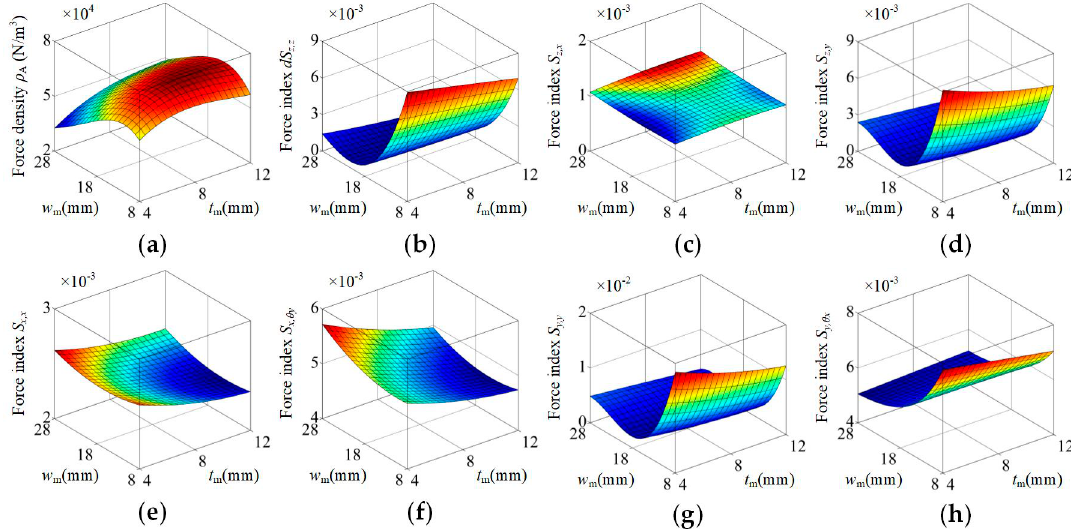
Figure 13. Force density and uniformity of the HMF-VCA varied with structural parameters w m and t m . ( a ) Force density ρ A . ( b ) Variation of F z caused by z . ( c ) Variation of F z caused by x . ( d ) Variation of F z caused by y . ( e ) Variation of F x caused by x . ( f ) Variation of F x caused by θ y . ( g ) Variation of F y caused by y . ( h ) Variation of F y caused by θ x .